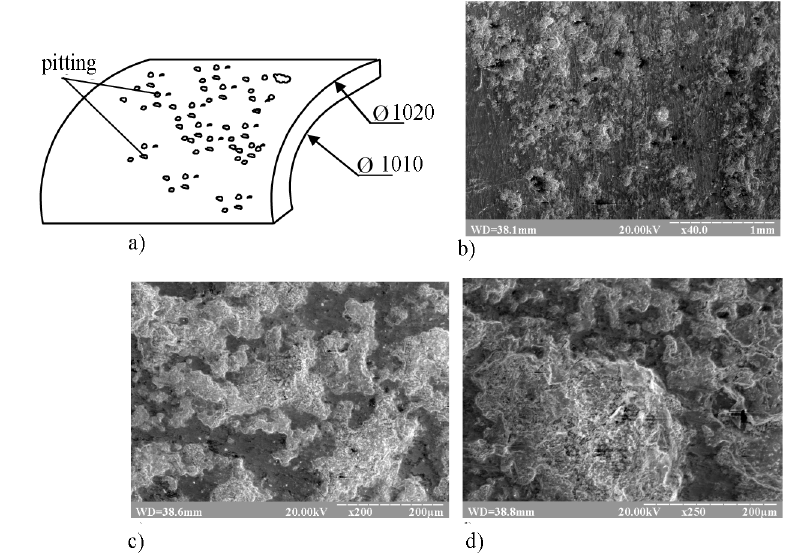
Fig. 3. Scheme of multiple pitting location on the pipe surface (а); local (b) and coalesced pitting